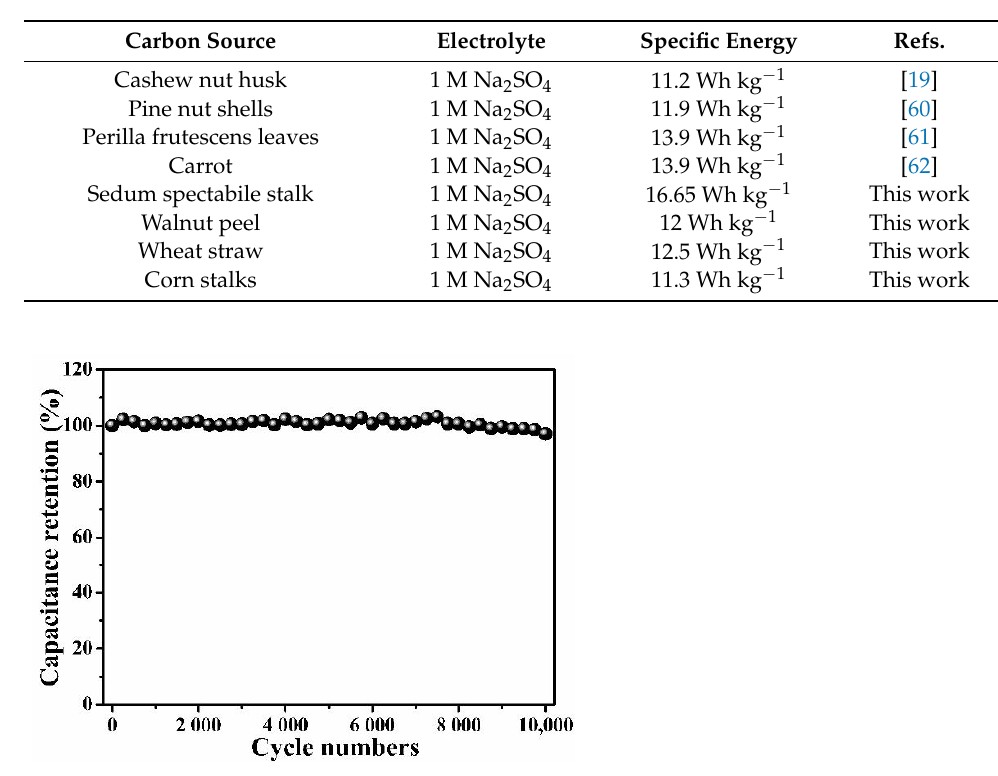
measurements; Figure S1: (a) SEM image and (b) XRD pattern of walnut-peel-derived porous carbon; (c) GCD curves in the three-electrode system and (d) specific capacitances at different current densities, Figure S2: (a) SEM image and (b) XRD pattern of wheat-straw-derived porous carbon; (c) GCD curves in the three-electrode system and (d) specific capacitances at different current densities, Figure S3: